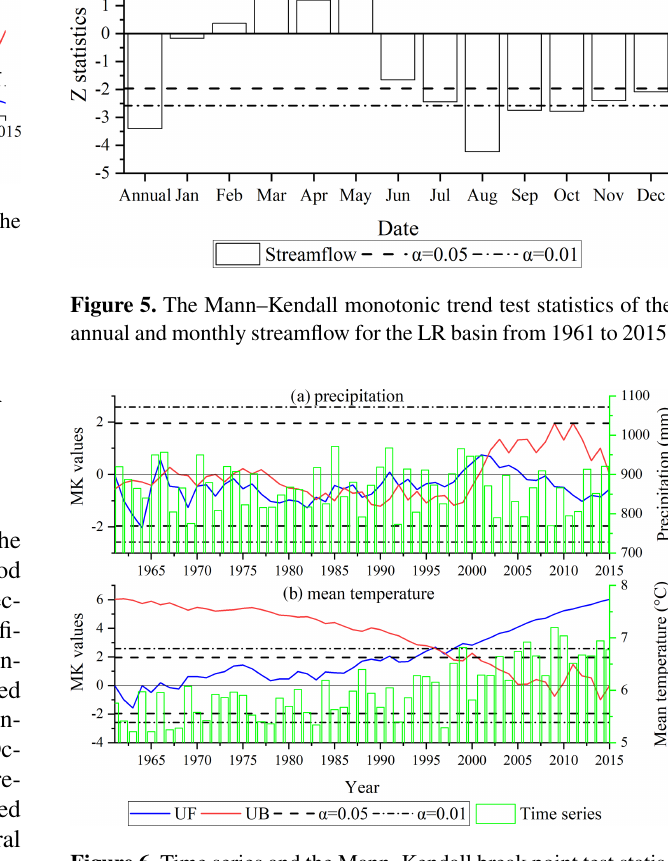
Figure 6. Time series and the Mann–Kendall break point test statis- tics of the annual precipitation (a) and mean temperature (b) in the LR basin from 1961 to